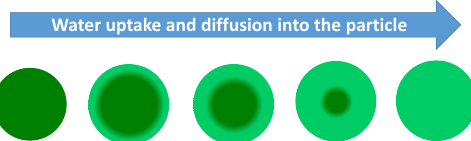
Figure 5. Schematics of water uptake and diffusion into an aerosol particle exposed to a fixed relative humidity with a sharp transition line distinguishing two homogeneous domains during diffusion: the dark green organic core and the light green organic–water shell that is in equilibrium with the gas-phase humidity.